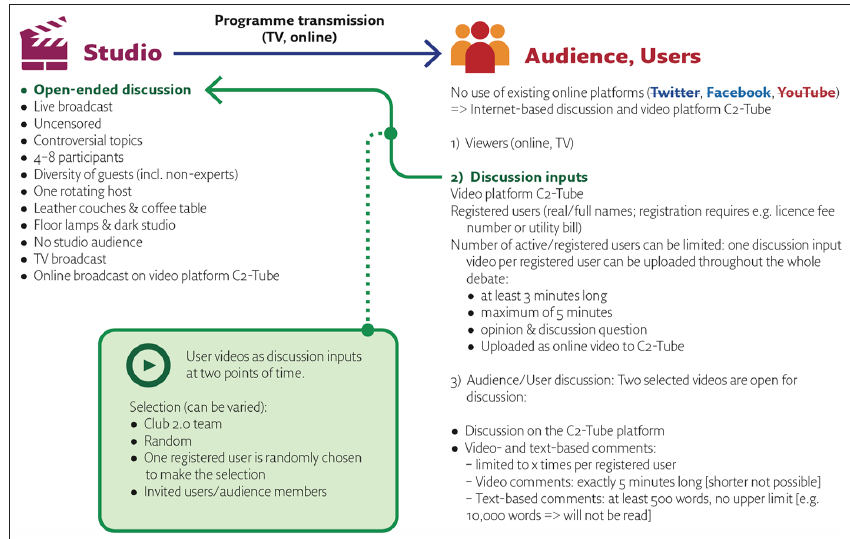
Figure 1: Club 2.0. Source : First published as CC in Fuchs (2018b: